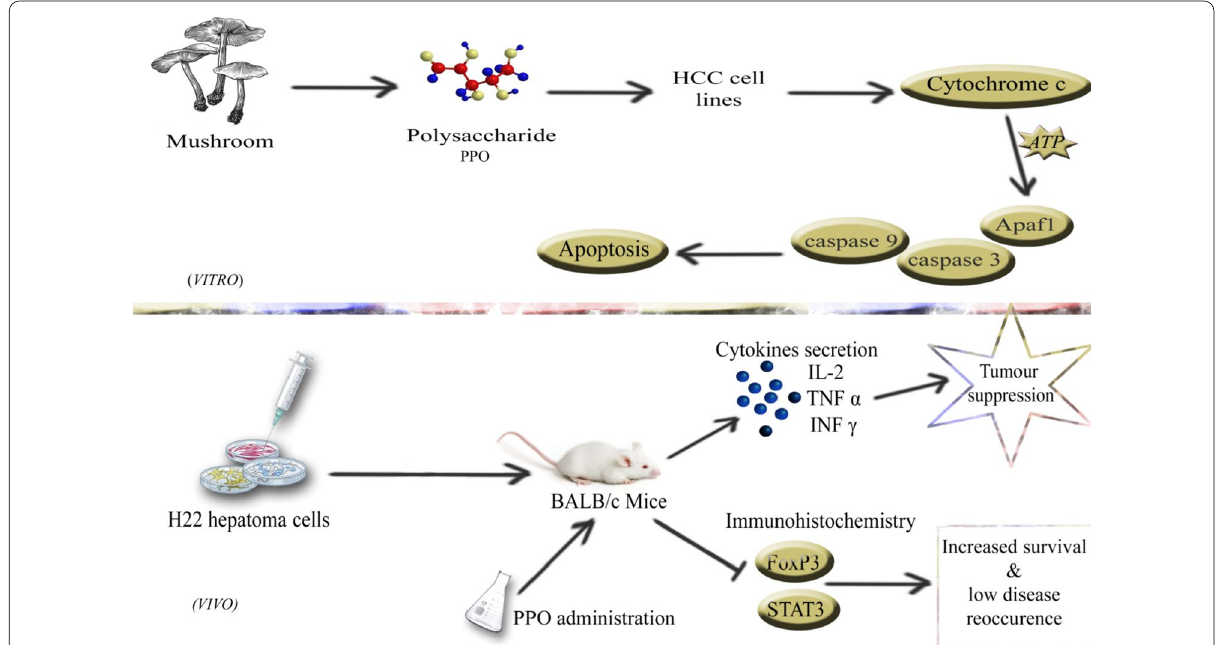
Fig. 7 A schematic diagram highlighted the mechanism of polysaccharide extracted from Pleurotus ostreatus inducing apoptosis via up-regulation of pro-apoptotic genes and downregulation of anti-apoptotic genes in vitro and explaining how this polysaccharide upon administration enhances the immune response in cancer acquired mice and promotes the secretion of cytokines and regulation of Foxp3 and Stat3 increase survival time and decrease the chances of disease